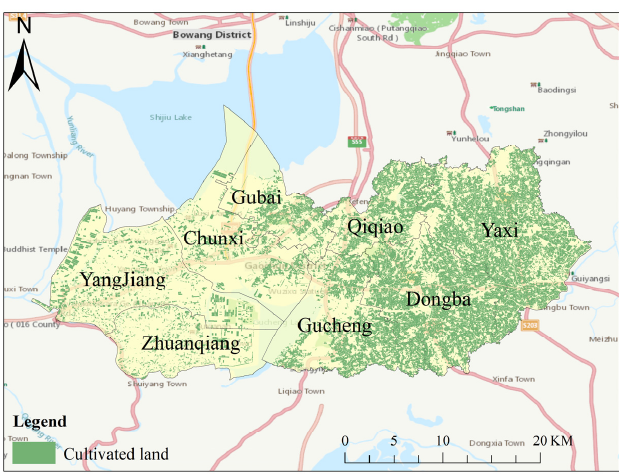
Figure 6. Inversion of cultivated land by the second national land survey.